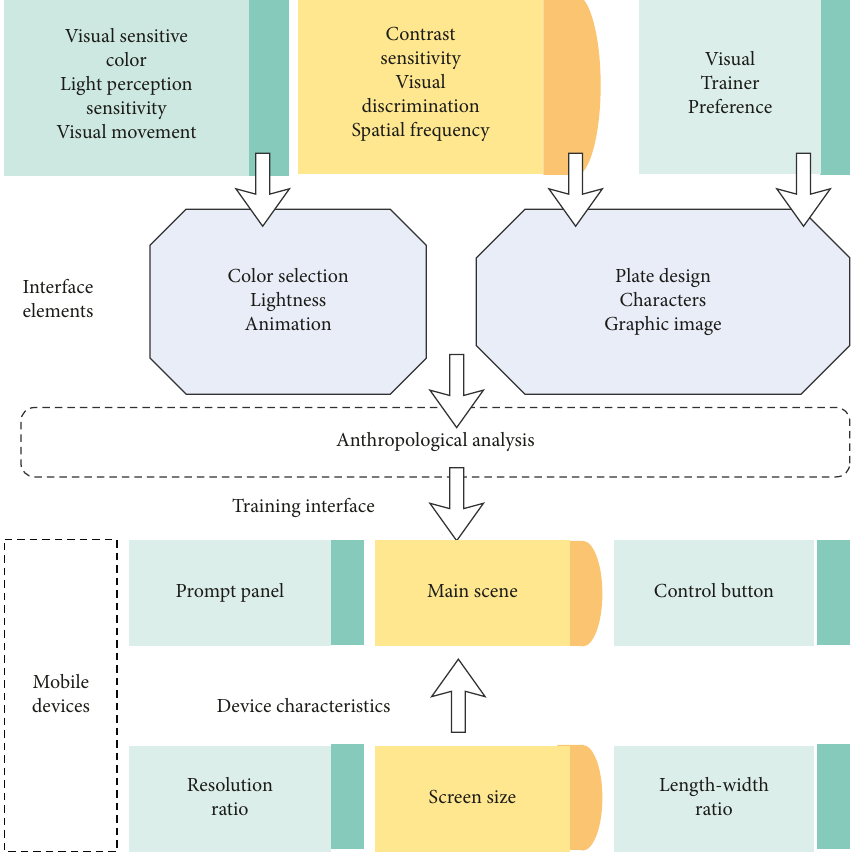
Figure 7: UI design mode of visual training software in a mobile terminal